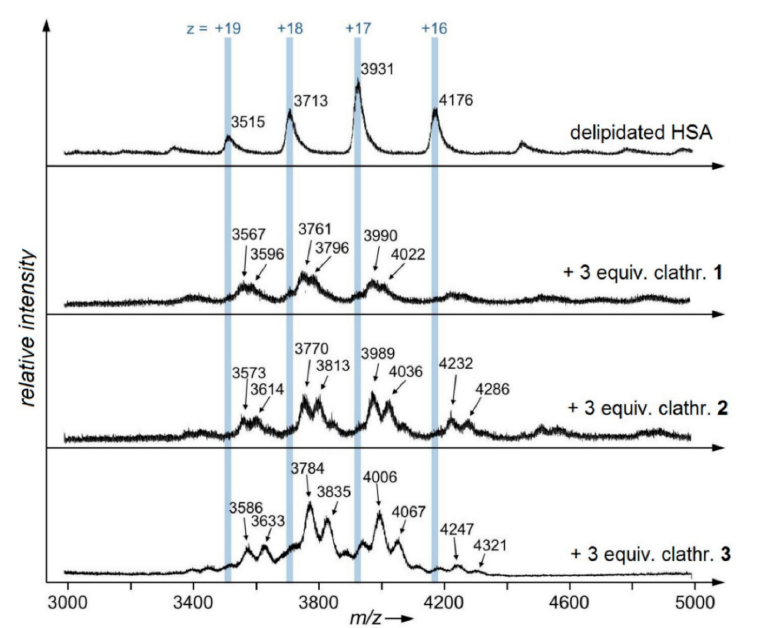
Figure 3. Native electrospray ionization (ESI) mass spectrum of the human serum albumin (HSA; delipidated) at its concentration of 20 µ M in the absence and in the presence of the clathrochelates 1 – 3 at their concentration of 60 µ M measured in 20 mM ammonium bicarbonate aqueous bu ff er. Table 3. Averaged deconvoluted masses (Da) of the detected charge states ( + 15 to + 19) of human serum albumin (HSA; delipidated) and its adducts with clathrochelates 1 – 3 . The mass di ff erences of the adducts with respect to unreacted HSA are given, as well as theoretical masses of clathrochelates. Deconvoluted Mass Mass Di ff erence Theoretical Mass of Species [Da] to Reference [Da] Compound [Da] Delipidated HSA 66,802 ± 21 + 1 67,721 ± 34 919 782 + 2 × 1 68,328 ± 32 2 × 763 2 × 782 + 2 67,800 ± 29 998 886 + 2 × 2 68,573 ± 36 2 × 885 2 × 886 + 3 68,052 ± 58 1250 1075 + 2 × 3 69,085 ± 64 2 ×